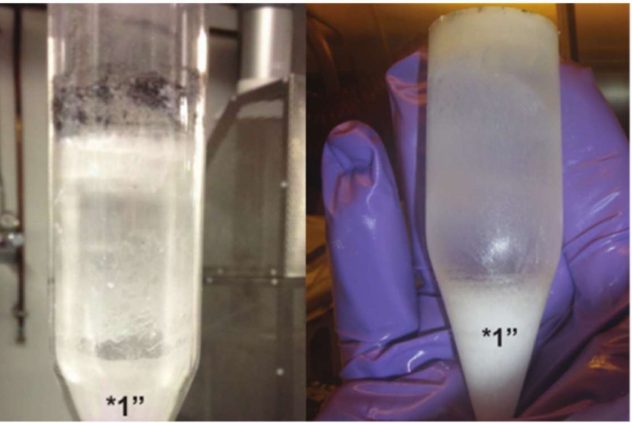
Figure 9. The photo of as-grown CLLC crystals by Saint-Gobain company. Reproduced with permis- sion [40]. Copyright 2013, Saint-Gobain